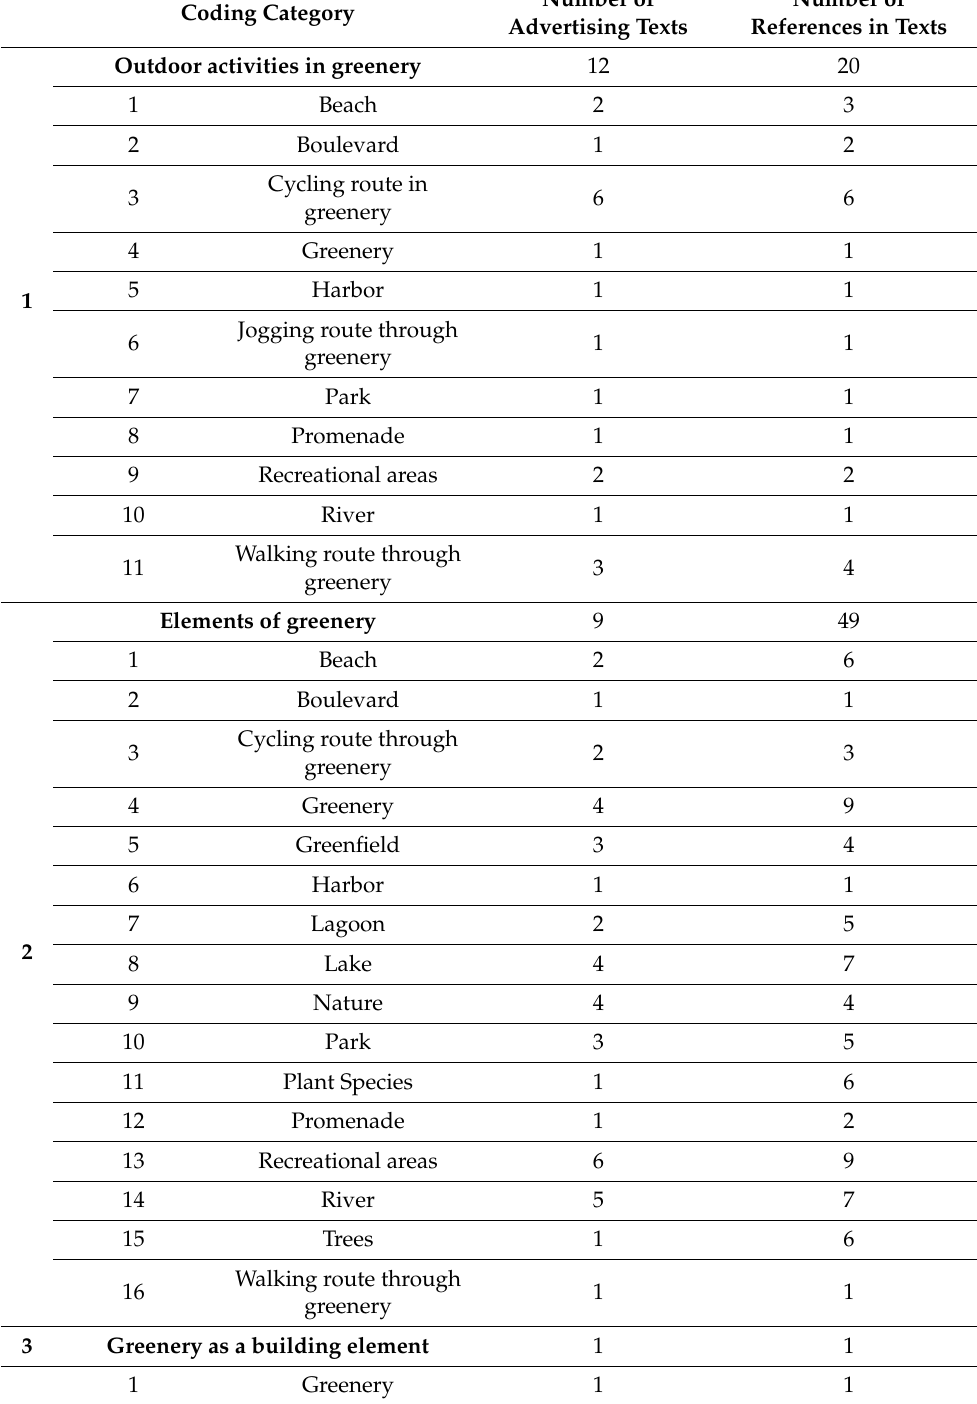
Table 4. Results of the second-stage